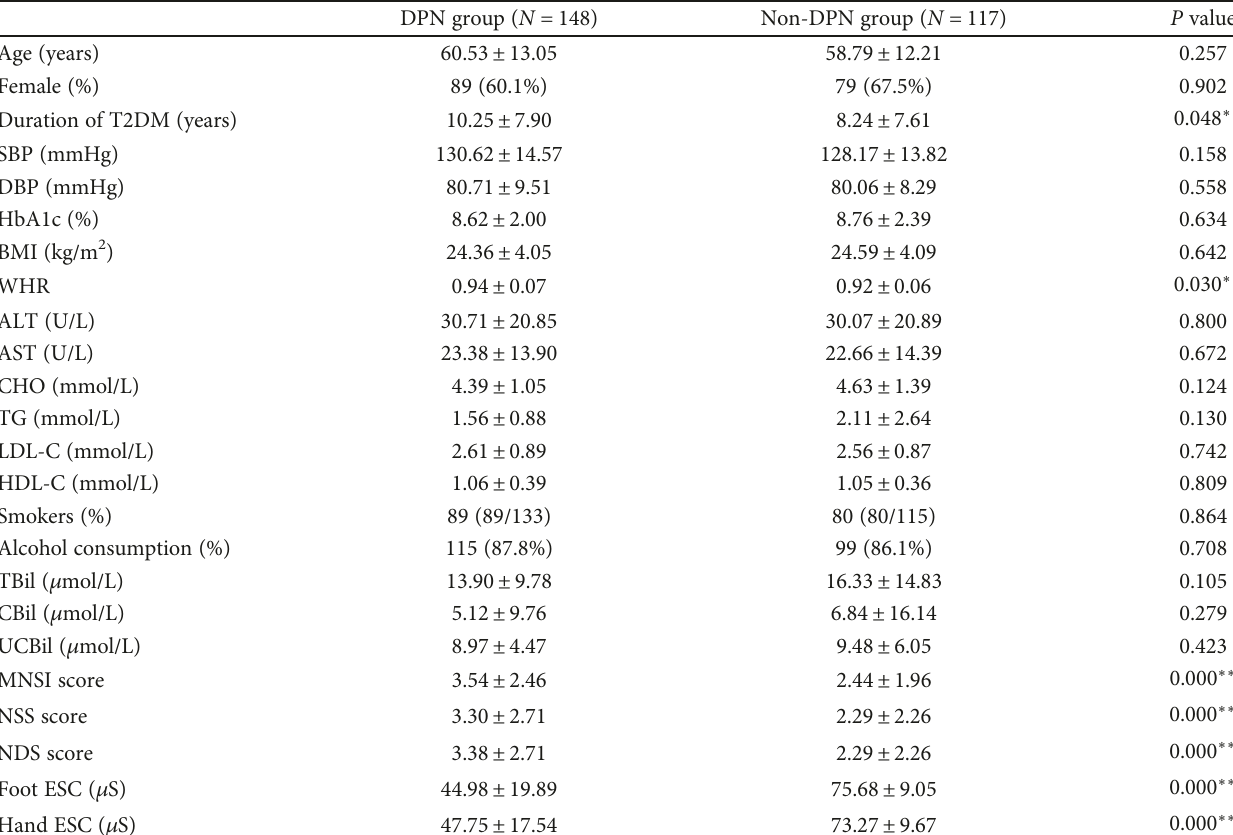
Table 2: Characteristics of 265 T2DM patients enrolled in the study divided by DPN diagnosed by the SUDOSCAN. DPN group ( N = 148 )